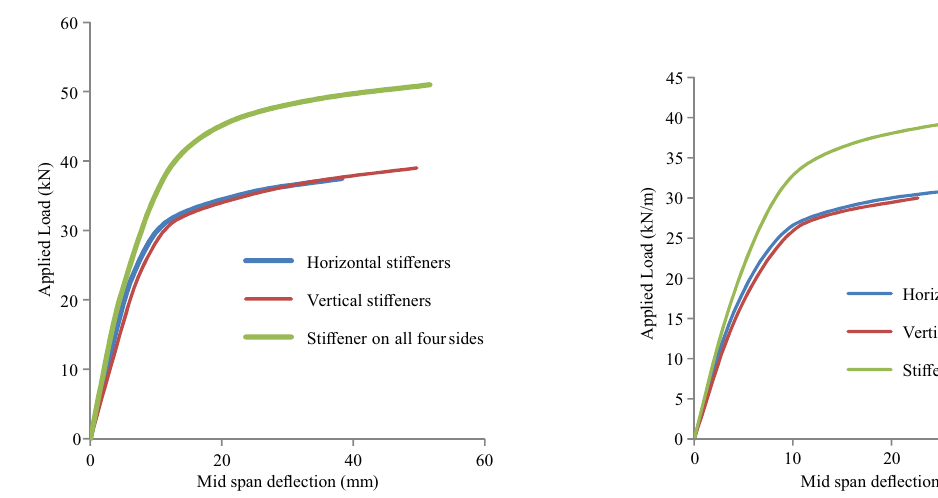
Fig. 14. Load vs mid span deflection for beam of different aspect ratio subjected to point load